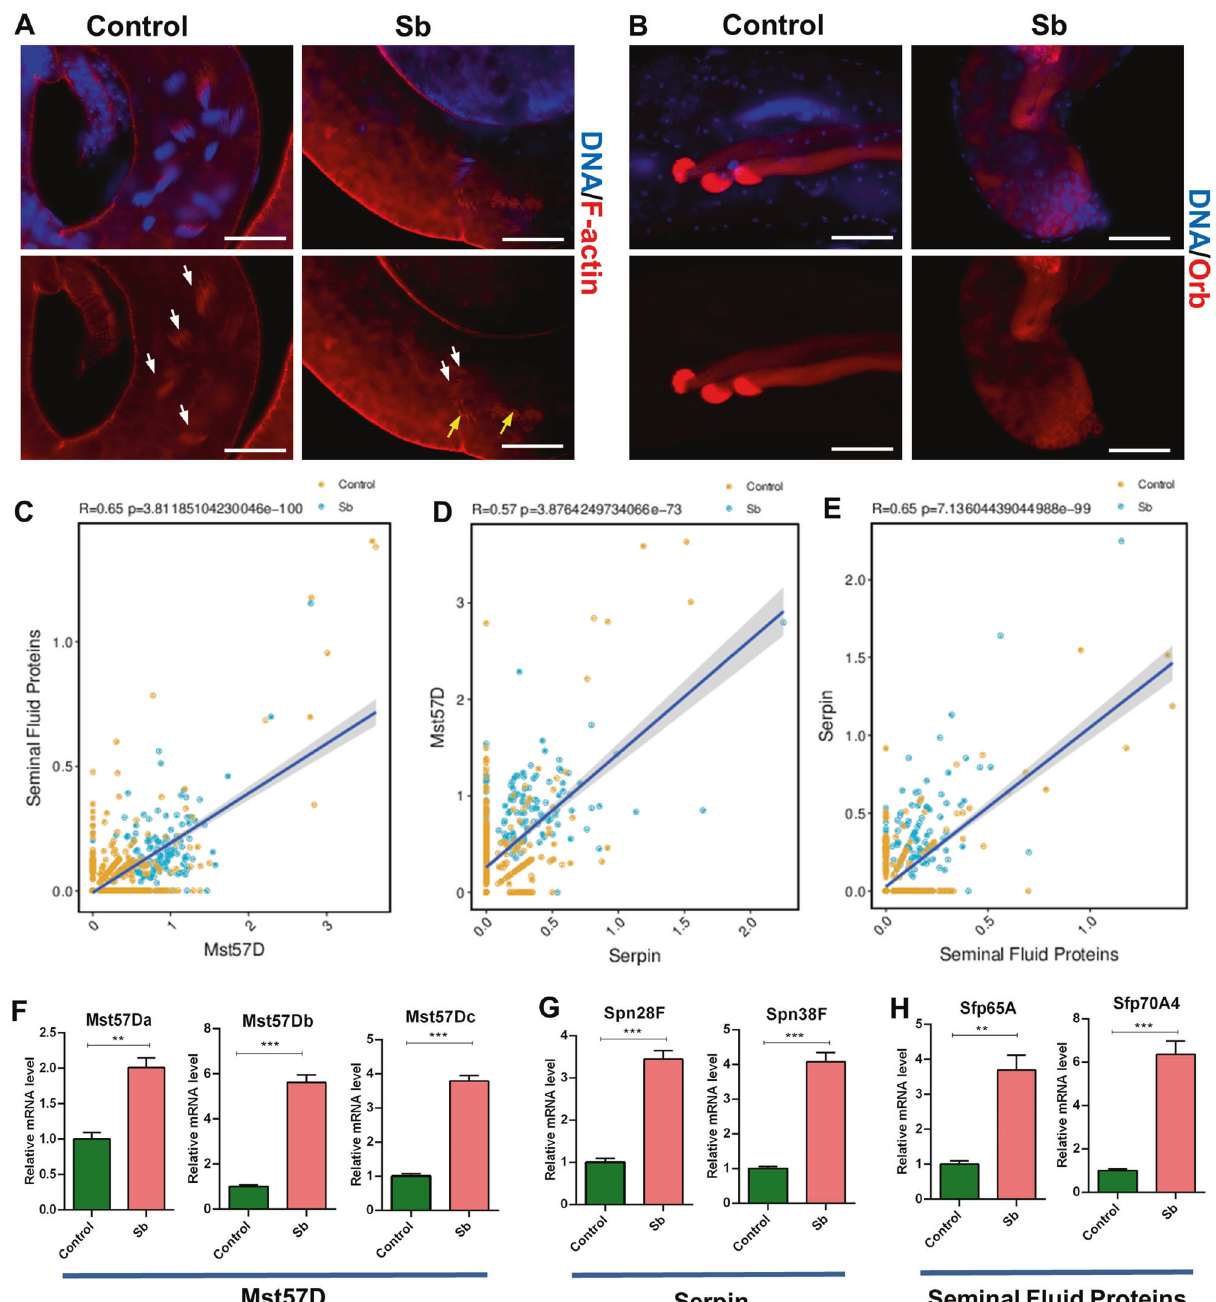
Fig. 5 Relevant molecular signaling in spermatid development. A F-actin staining for the investigation of IC structure in control and Sb testes. Representative ICs were shown with white arrows and abnormal IC structures were labelled with yellow arrows. B Immunostaining of Orb (red) mainly to label elongated spermatids in control and Sb testes. C Correlation analysis between Seminal Fluid Proteins and Mst57D signatures related in Spermatids cluster. D Correlation analysis between Mst57D and Serpin signatures in Spermatids cluster. E Correlation analysis between Serpin and Seminal Fluid Proteins signatures in Spermatids cluster. F qRT-PCR analysis of representative DEGs for Mst57D signature in testes. G qRT-PCR analysis of representative DEGs for Serpin signature in testes. H qRT-PCR analysis of representative DEGs for Seminal Fluid Proteins signature in testes. DNA was stained with Hoechst33342 (blue). ** P < 0.01, *** P < 0.001, scale bar: 50 μ analysis of germ cell maturation during spermatogenesis three major signatures in Drosophila testes following Sb exposure (Fig. 6A), and identi fi ed three novel states in Drosophila testes during spermatid development. (Fig. 6B). By analyzing the cellular components in each state, we showed that the germ cells were consistent with differ- Pseudotime trajectory analysis demonstrated three novel entiative stages (Fig. 6C). It is worth noting that both the states for Sb exposure during spermatogenesis number and fraction of germ cells in each state were To further investigate the germ cell features in Drosophila testes dramatically reduced following Sb exposure (Fig. 6D, E). following Sb exposure, we conducted a pseudotime trajectory